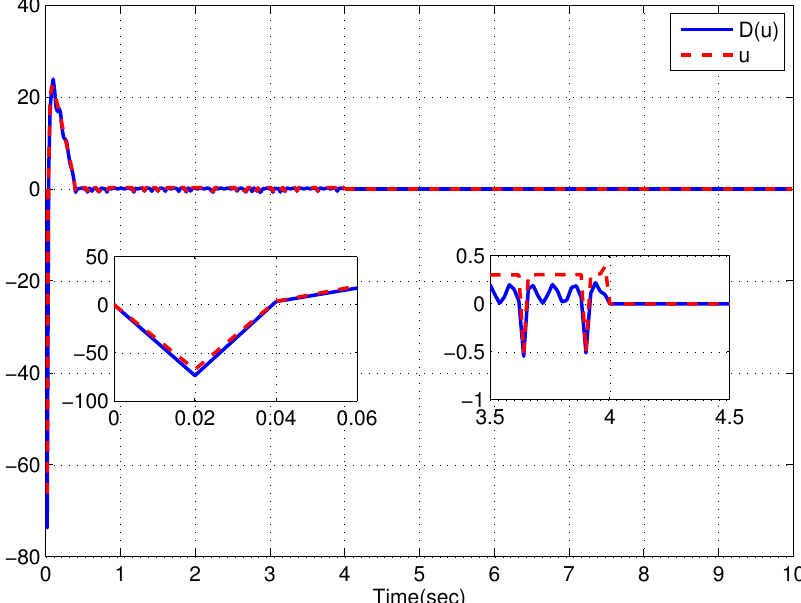
Figure 3. The input responses of the CLS with initial condition ( z 1 ( 0 ) , z 2 ( 0 )) = ( 0.5, − 1 )